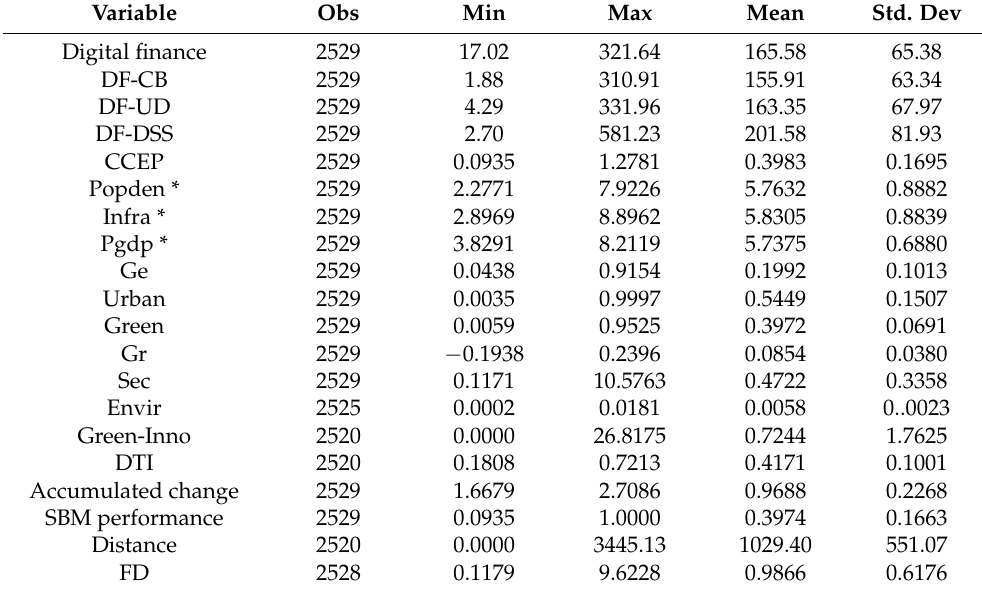
Table 2. Summary statistics of regression